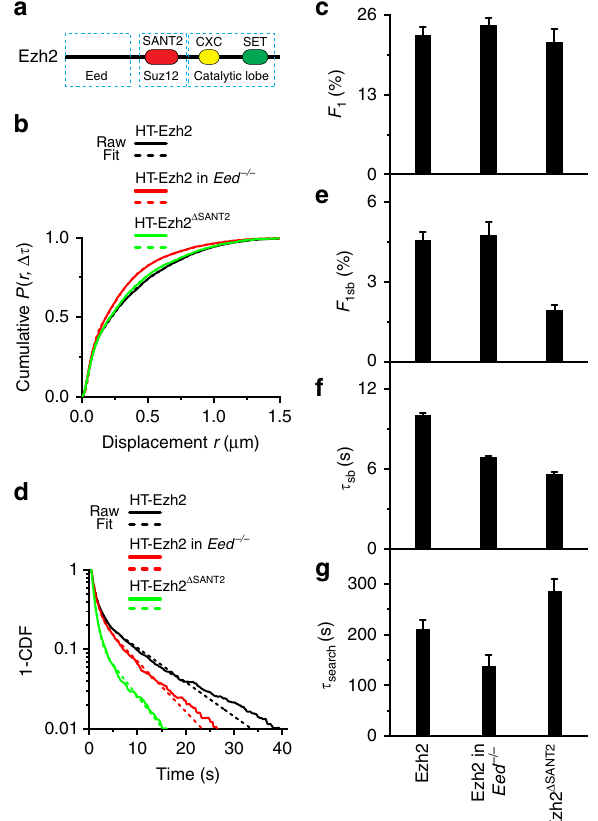
Fig. 3 Eed and Suz12 are required for the stability of Ezh2 on chromatin, but have different effects on its target search process. a Schematic representation of Ezh2. The N-terminus of Ezh2 interacts with Eed. The SANT2 domain (red rectangle) interacts with Suz12. The C-terminus of Ezh2 is the catalytic lobe, including cysteine-rich domain (CXC, yellow rectangle) and SET domain (green rectangle) that is the catalytic domain of Ezh2. b Cumulative distribution of displacements for HaloTag-Ezh2 replicated from Fig. 1, for HaloTag-Ezh2 ( N = 64 cells, n = 11437 displacements) in Eed − / − mES cells, and for HaloTag-Ezh2 Δ SANT2 ( N = 71 cells, n = 5981 displacements) in wild-type mES cells. The cumulative distributions were fi tted with three populations. Fitted parameters are shown in Supplementary Table 3. c Fraction of the chromatin-bound population ( F 1 ) obtained from Fig. 3b. Results are means ± SD. d Survival probability distribution of the dwell times for HaloTag-Ezh2 replicated from Fig. 2, for HaloTag-Ezh2 ( N = 93 cells, n = 2339 trajectories) in Eed − / − mES cells, and for HaloTag-Ezh2 Δ SANT2 ( N = 85 cells, n = 2728 trajectories) in wild-type mES cells. The distributions were fi tted with a two-component exponential decay model. Fitted parameters are shown in Supplementary Table 4. e – g Fraction ( e ), residence time ( f ), and search time ( g ) of the long-lived population ( F 1sb ) for HaloTag-Ezh2 replicated from Fig. 2, for HaloTag-Ezh2 in Eed − / − mES cells, and for HaloTag-Ezh2 Δ SANT2 in wild-type mES cells. Results are means ± SD from three biological